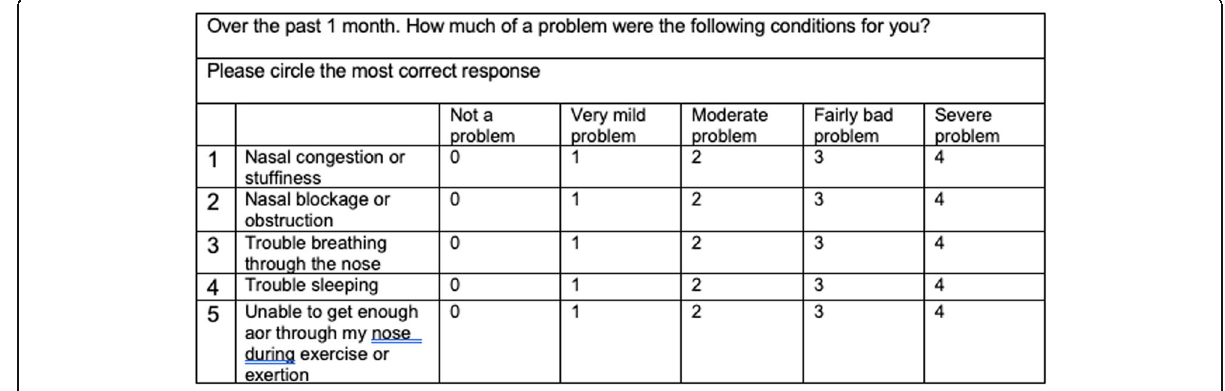
Fig. 1 The English version of the NOSE